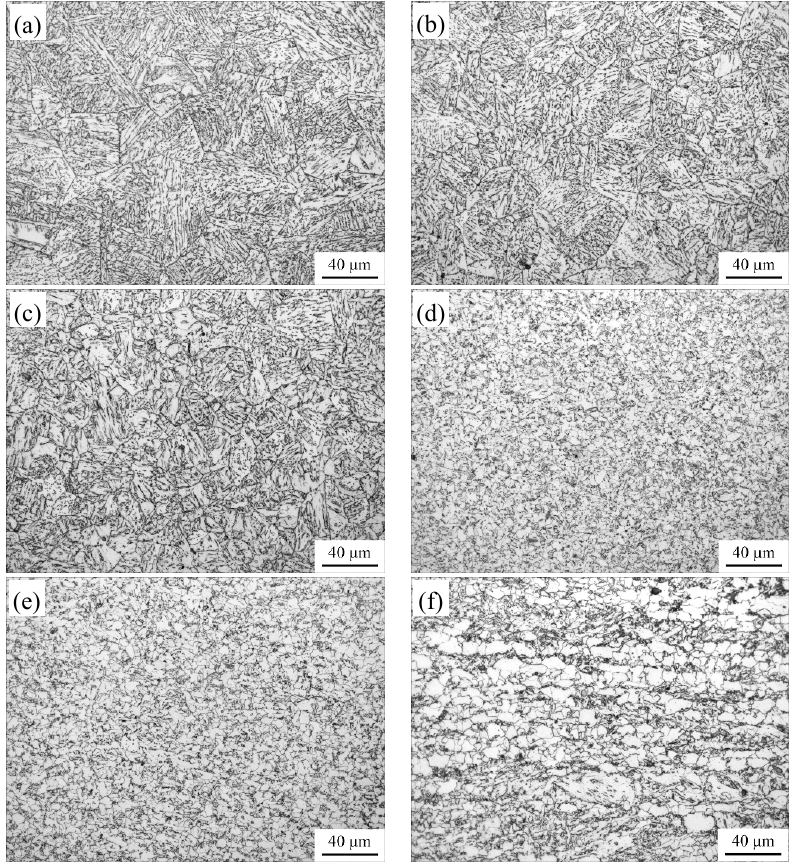
Figure 3. OM images of the simulated welded microstructures ( a ) 1350 °C; ( b ) 1250 °C; ( c ) 1150 °C; ( d ) 1050 °C; ( e ) 950 °C; ( f ) 850 °C.